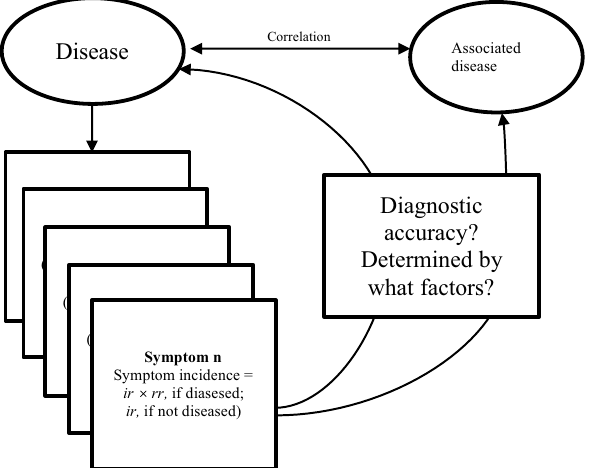
Figure 1. Elements of the simulations in this study. d proportions diseased, ir incidence rate, rr risk